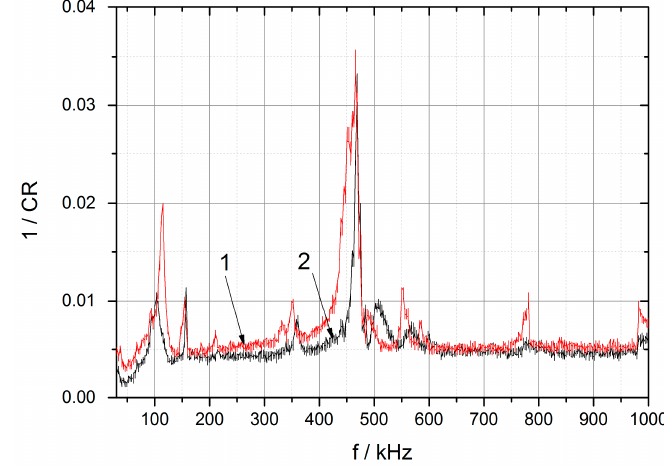
Figure 6. The dependences of Pockels cells BBO crystal contrast ratio on applied high-voltage pulse frequency for crystals with various dimensions: 1– 4 × 4 × 20 mm; 2 – 4 × 4 × 25 mm.